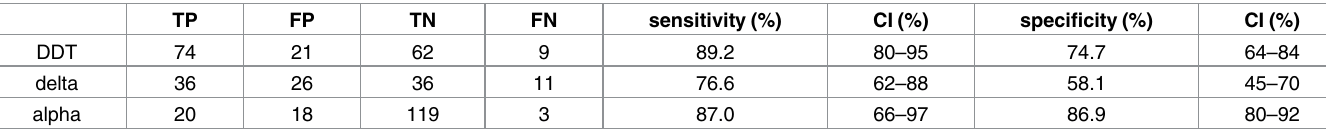
delta = deltamethrin; alpha = alpha-cypermethrin. TP = true positive (alive and kdr -only genotype); FP = false positive (dead and kdr -only genotype); TN = true negative (dead and wt -leucine genotypes); FN = false negative (alive and wt -leucine genotypes); sensibility = TP/(TP+FN); specificity = TN/(TN +FP); CI = 95% confidence interval